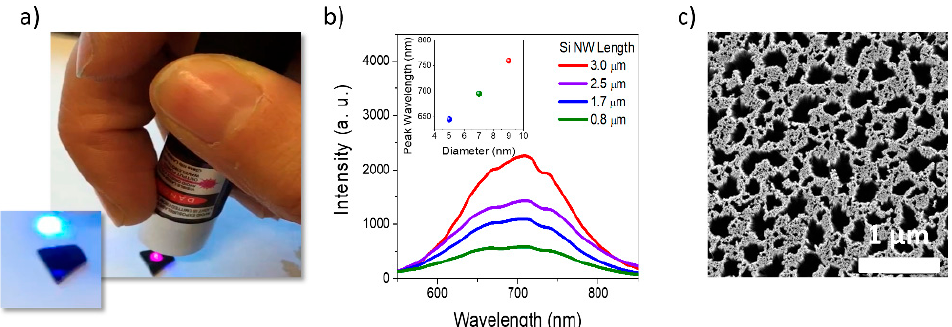
Figure 2. ( a ) Photo attesting the bright room temperature emission observed by the naked eye and under excitation by a commercial laser pointed at a wavelength of 405 nm, the inset shows the same laser onto white paper. ( b ) Photoluminescence emission of NWs with the same diameter but different lengths, while the inset shows the normalized photoluminescence emission from Si NWs with a different average diameter under excitation with 488 nm line from an Ar + laser. ( c ) SEM plan-view of 2 μ m long fractal Si NW array showing the fractal design along the xy plane.